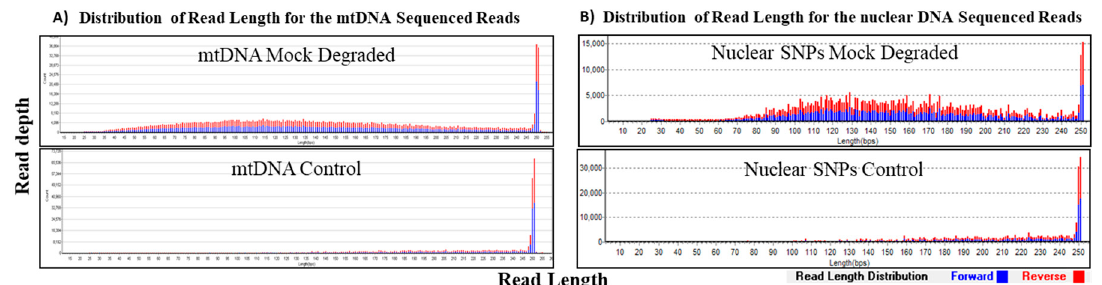
Figure 4. Sequencing results of mock degraded and control samples at 1 ng. Distribution of read length ( x -axis) at corresponding coverage ( y -axis) was determined for the mock degraded mtDNA sample and the control sample. Forward reads are in blue and the reverse reads are in red. ( A ) The average read length for the control mtDNA sample was ~200 bp and that of mock degraded mtDNA sample was ~150 bp. ( B ) For the nuclear SNPs control sample, the average read length was ~200 bp and ~150 bp for the mock degraded nuclear SNPs sample.